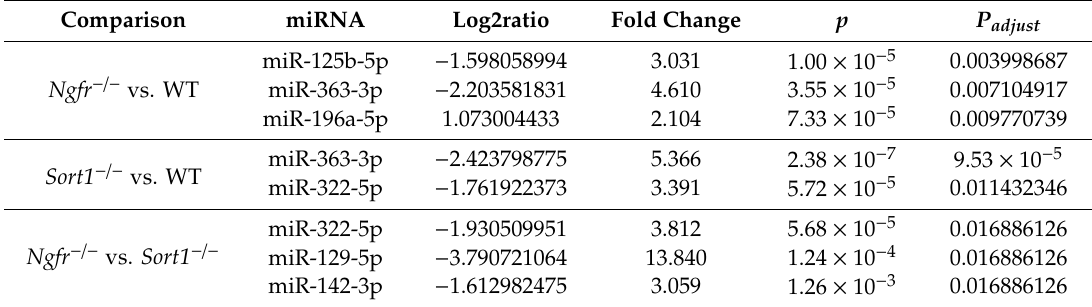
Table 7. The most di ff erentially expressed miRNAs in EVs from rat primary Schwann cells lacking p75 NTR or